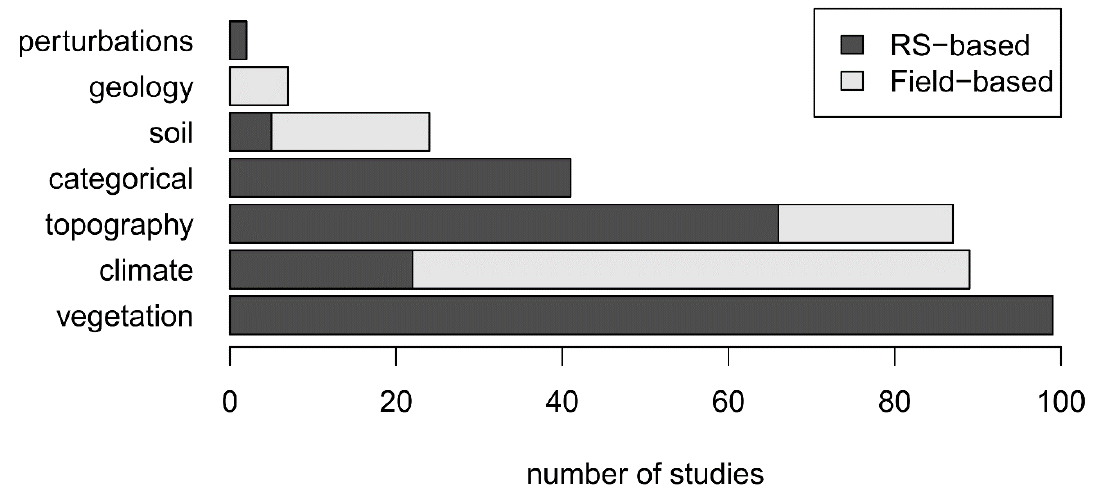
Figure 2. Number of studies reviewed that used each type of environmental variable based on remote sensing (RS) or field plots. Studies that used multiple variables were counted several times.